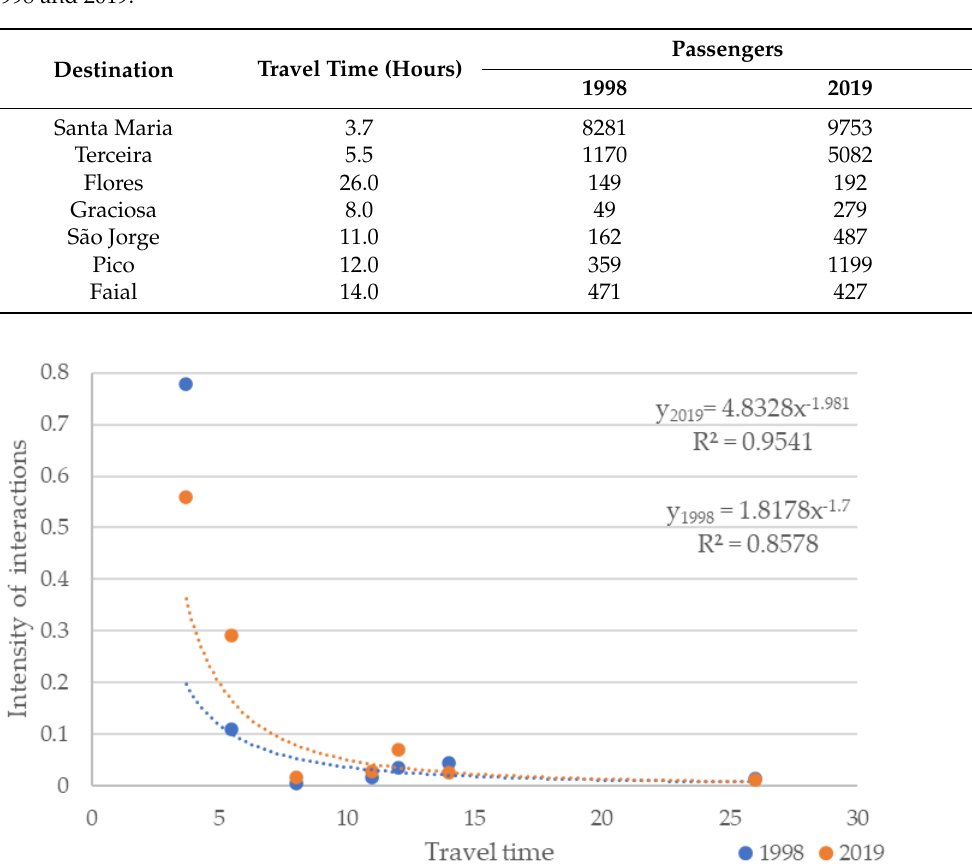
Figure 8. Intensity of interactions and travel time to São Miguel Island from the rest of the archipelago — for 1998 and 2019.